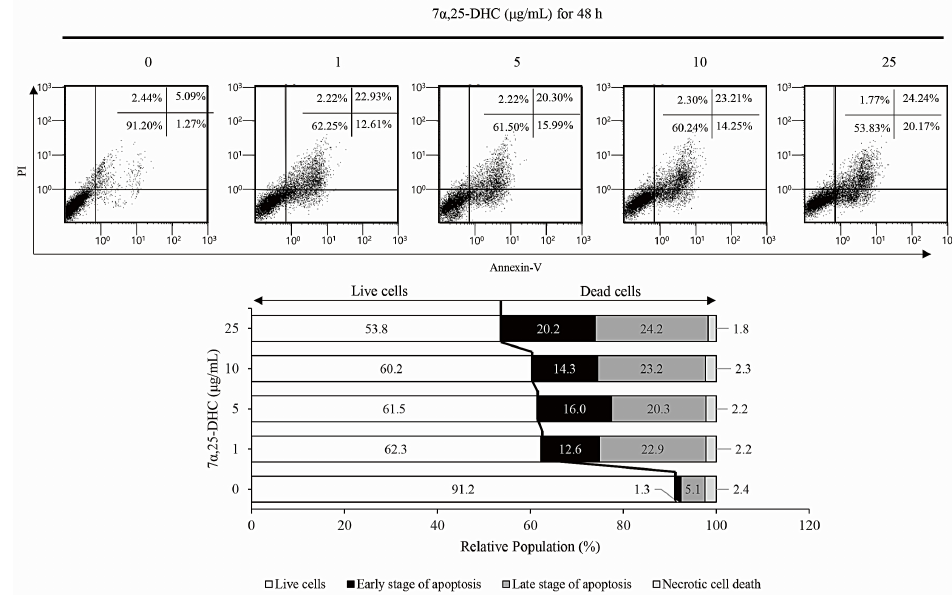
Figure 4. The apoptotic population was enhanced by 7 α ,25-DHC in L929 cells. Apoptotic population was analyzed by FACS using PI and annexin V labeling in L929 cells incubated with 1, 5, 10, and 25 µ g/mL 7 α ,25-DHC for 48 h.